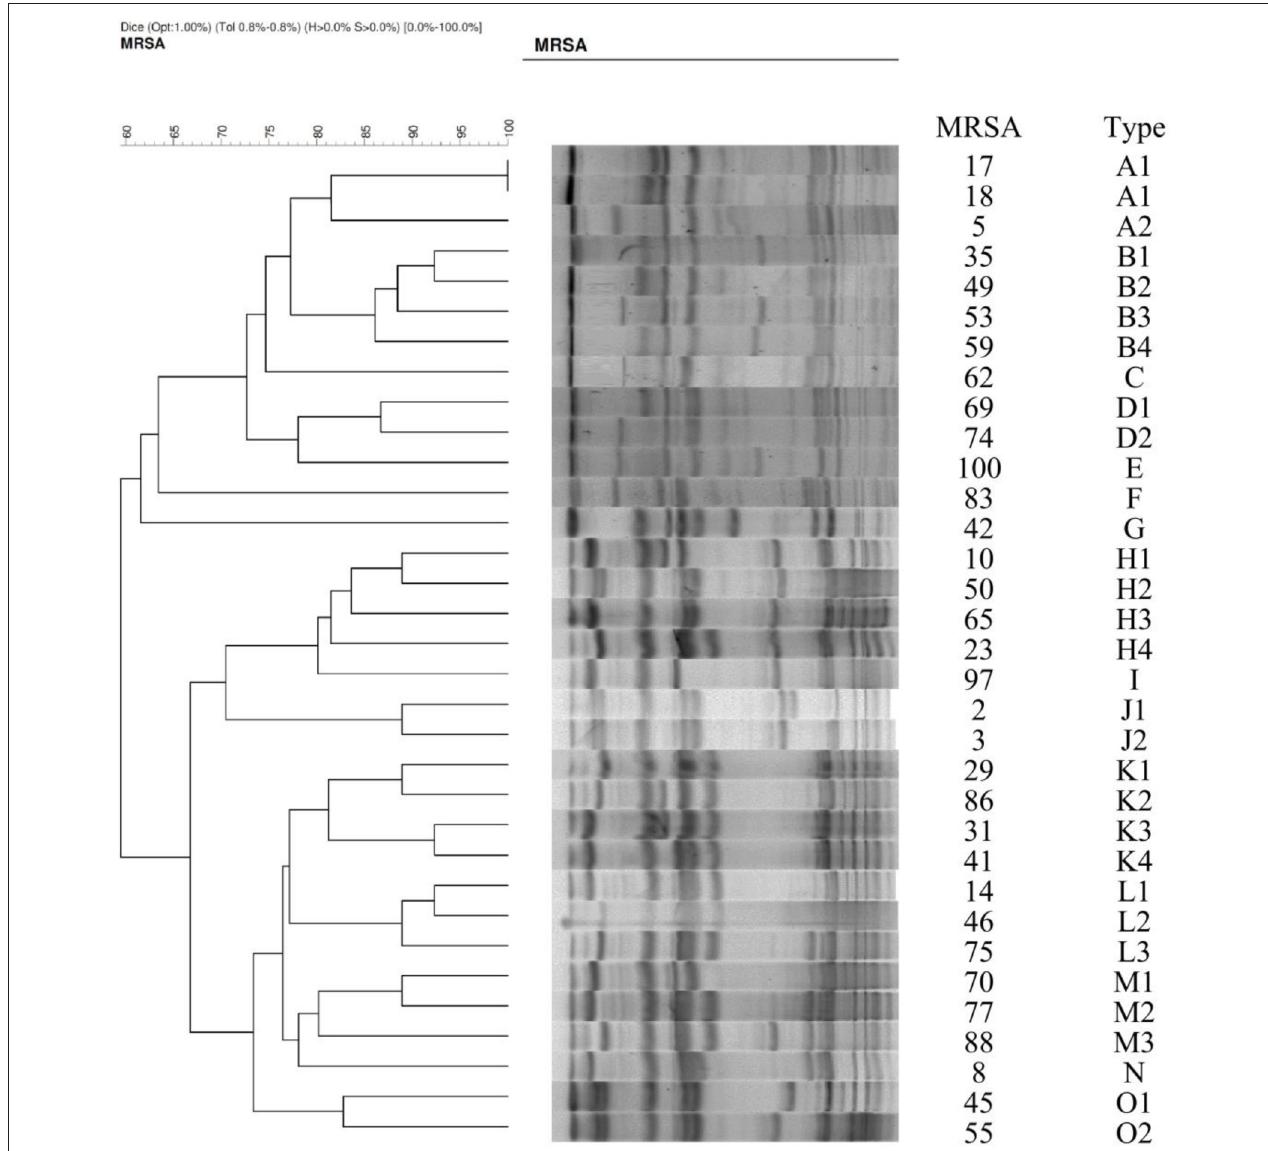
FIGURE 2 | PFGE profiles for 34 clinical isolates of methicillin-resistant Staphylococcus aureus